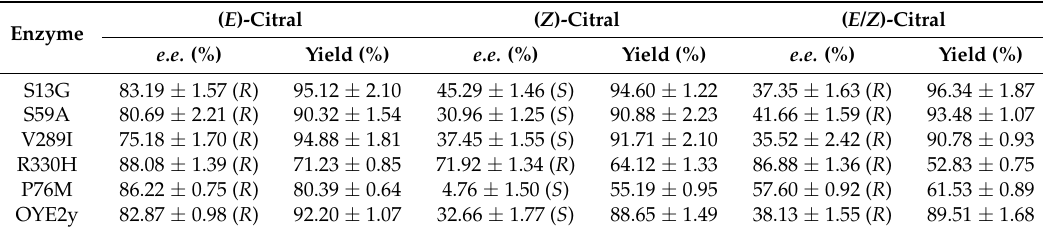
Table 1. The catalytic performance of OYE2y and its variants S13G, S59A, P76M, V289I, and R330H a .